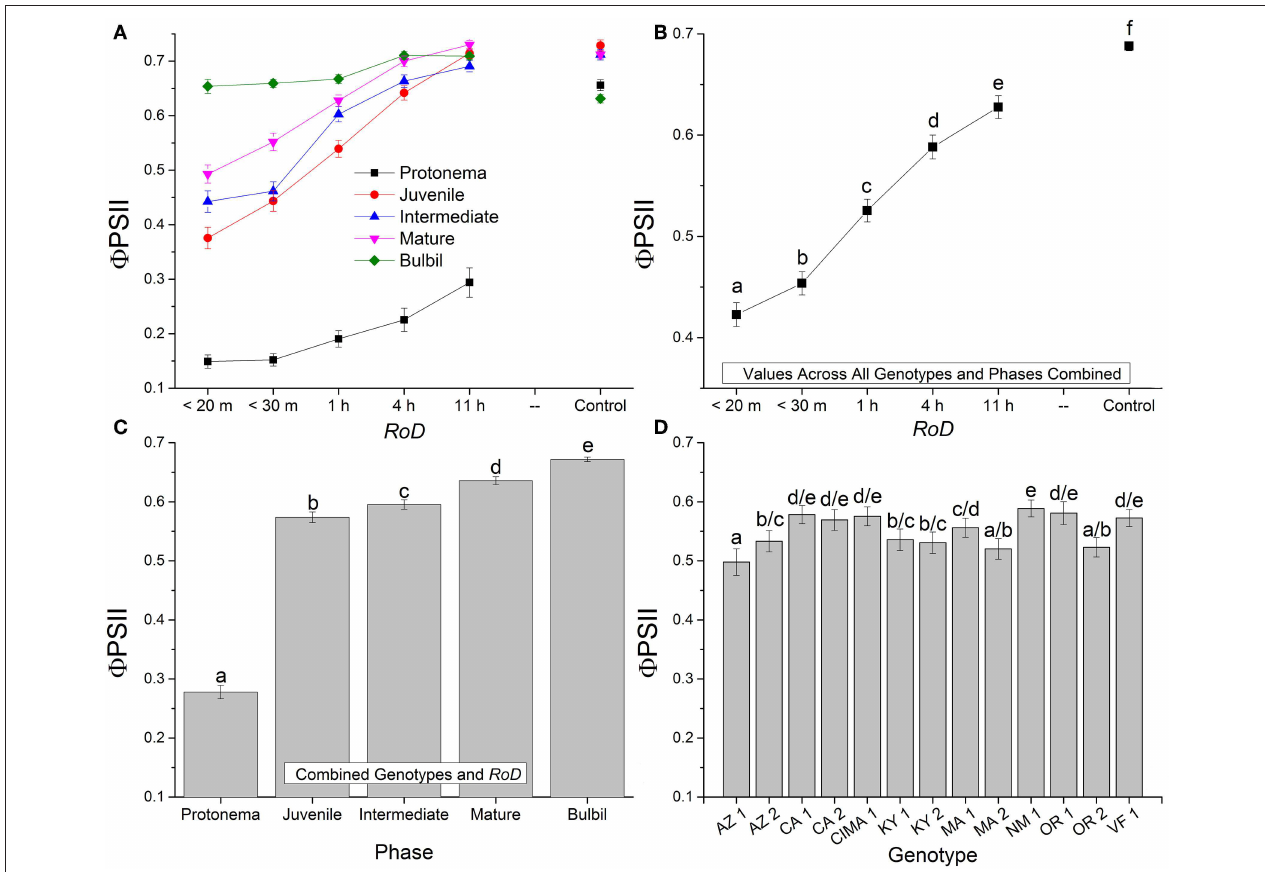
FIGURE 2 | Bryum argenteum 8 PSII Response variables. Panel of images showing Bryum argenteum 8 PSII response variables 24h post rehydration for the treatment combinations indicated, error bars represent ± 1 SE, and lowercase letters represent homogeneous subsets established at an α of 0.05. (A) Two-way interaction between rate of drying (RoD) and life phase ( n = 65), (B) Main effect of RoD among life phase and ecotypes combined ( n = 390), (C) Main effect of life history phase among RoD and ecotype ( n = 390), (D) The effect of ecotype with all life phases and RoD treatments combined ( n = 150). RoD, Rate of